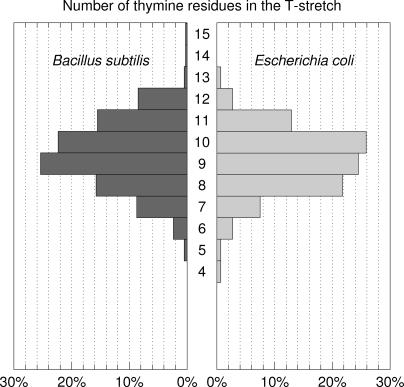
Distribution of the Number of Thymine Residues in the 15 Base Pair T-Stretch following the Stem LoopThe distribution is calculated from 425 transcriptional terminators in B. subtilis, and 147 previously published Rho-independent terminators in E. coli [16].